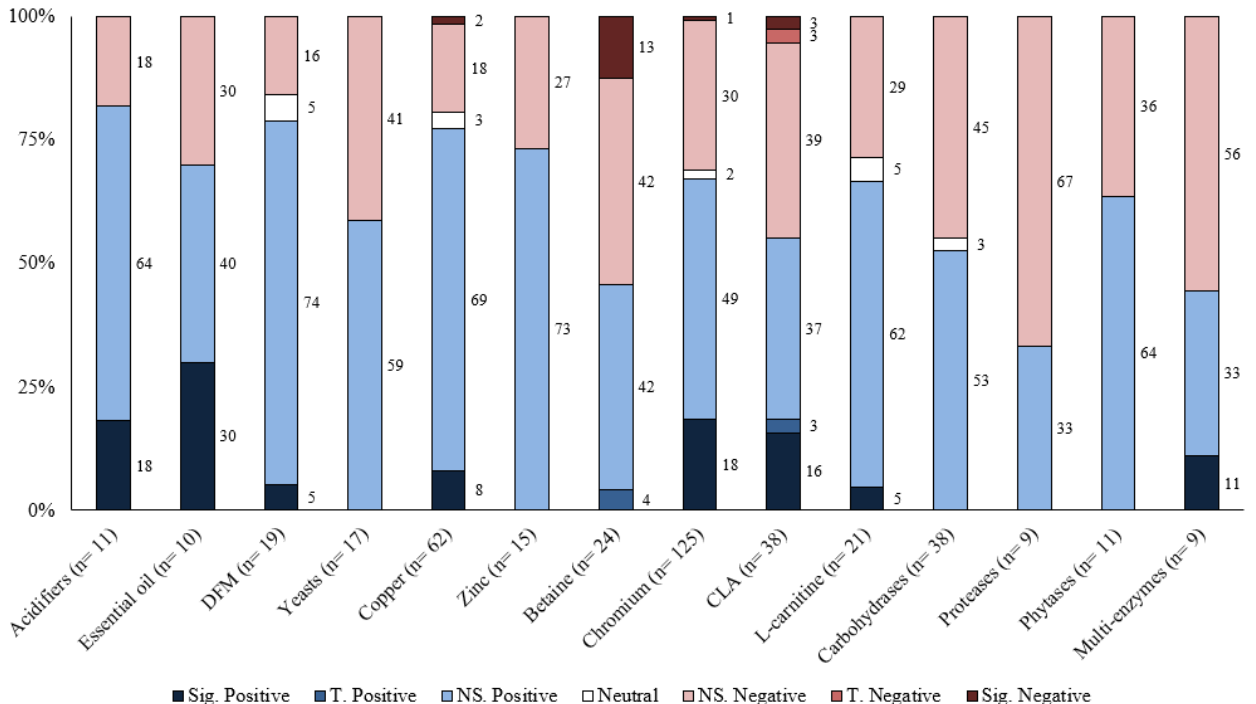
Figure 5. The distribution of results for various feed additives on longissimus muscle area/loin depth by significance level and direction. The comparison was significant (Sig.) if p ≤ 0.05, had a tendency (T.) if 0.05 < p ≤ 0.10, and was non-significant (NS.) if p > 0.10.